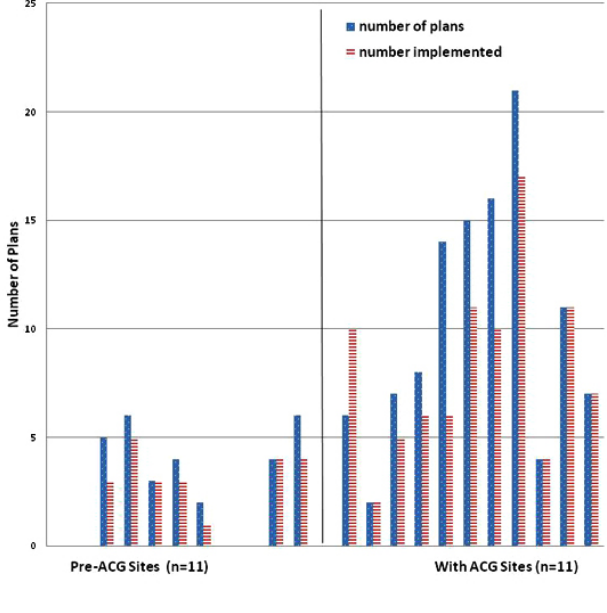
Fig. 3 . Perception of distributional equity: comparing marginalized and nonmarginalized members in the pre- and with-adaptive collaborative governance periods (n = 11). Notes: Perception of distributional equity refers to perceptions of equity regarding access to key forest products (timber, nontimber forest products, fodder, fuelwood), community forest user groups (CFUG) loans and income generation activities, and trainings. Pre-ACG = prior to adaptive collaborative governance; with ACG = with adaptive collaborative governance, i.e., by study final assessments. Marginalized members = poor, Dalit, and female members (all nonexecutive committee). Nonmarginalized members = rich and medium wealth group, male, non- Dalit members, and executive committee members. A comparison of marginalized members perceptions from the pre-ACG and with ACG periods (the 1st and the 3rd columns) indicates an increase in perception of equity among marginalized members. Comparison of both groups of members across these periods (the 1st and 2nd columns compared with the 3rd and 4th columns) illustrates a decrease in the gap between perceptions of marginalized and nonmarginalized members. Source: Pebble distribution exercises, 2006.